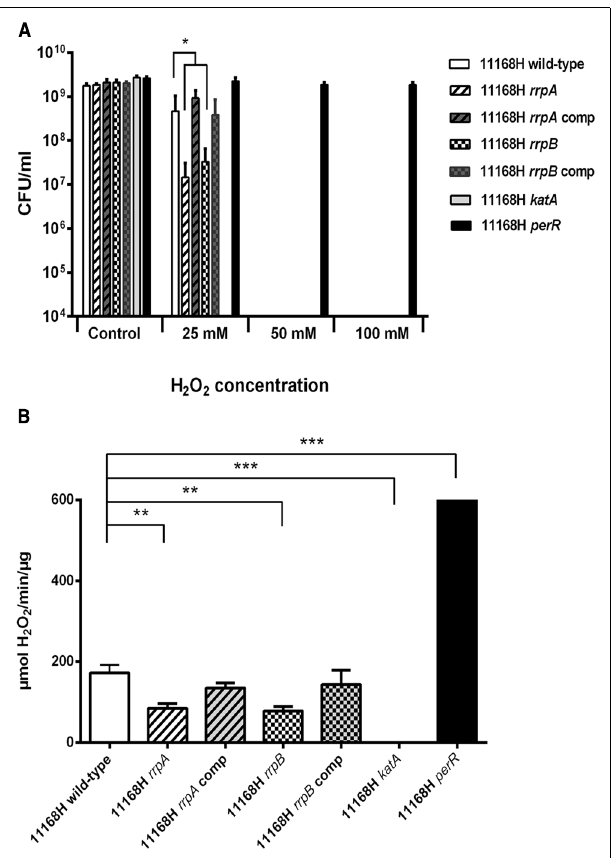
FIGURE 2 | (A) Effect of oxidative stress on the survival of C. jejuni 11168H wild-type strain, rrpA , rrpA complement strain ( rrpA comp), rrpB , rrpB complement strain ( rrpB comp), katA and perR mutants. C. jejuni strains were incubated with 25, 50, or 100 mM H 2 O 2 for 15 min at 37°C then bacterial survival assessed. (B) Catalase activity assays were performed on bacterial whole cell lysates from the 11168H wild-type strain, rrpA , rrpA comp, rrpB , rrpB comp, katA and perR mutants for 1 min. Asterisks denote a statistically significant difference (* p < 0.05, ** p < 0.01, *** p < 0.001).